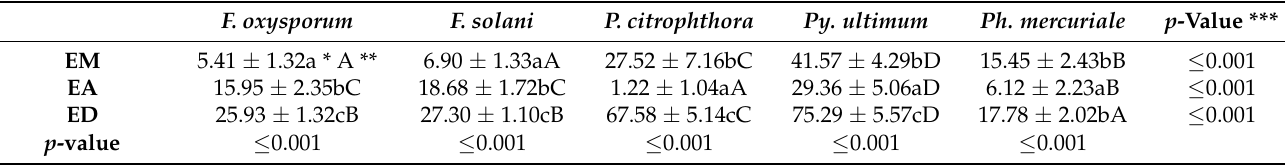
Table 4. Antifungal potential (percent hyphal growth inhibition) of Raphanus raphanistrum organic extracts toward Py. ultimum and Ph. mercuriale noted after 2 days and F. oxysporum , F. solani , and P. citrophthora noted after 6 days of incubation at 25 ◦